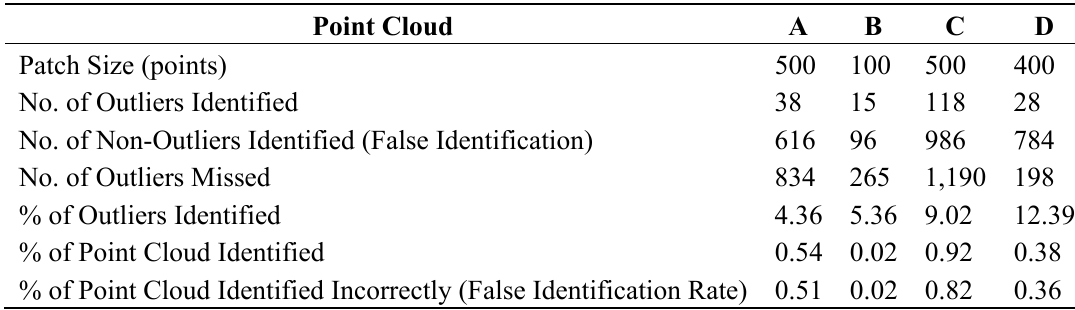
Table 4. Results from trials conducted using Quadratic Polynomial Surface Fitting (CSF) on point clouds A, B, C and D using test statistic 1 in Equation (28).